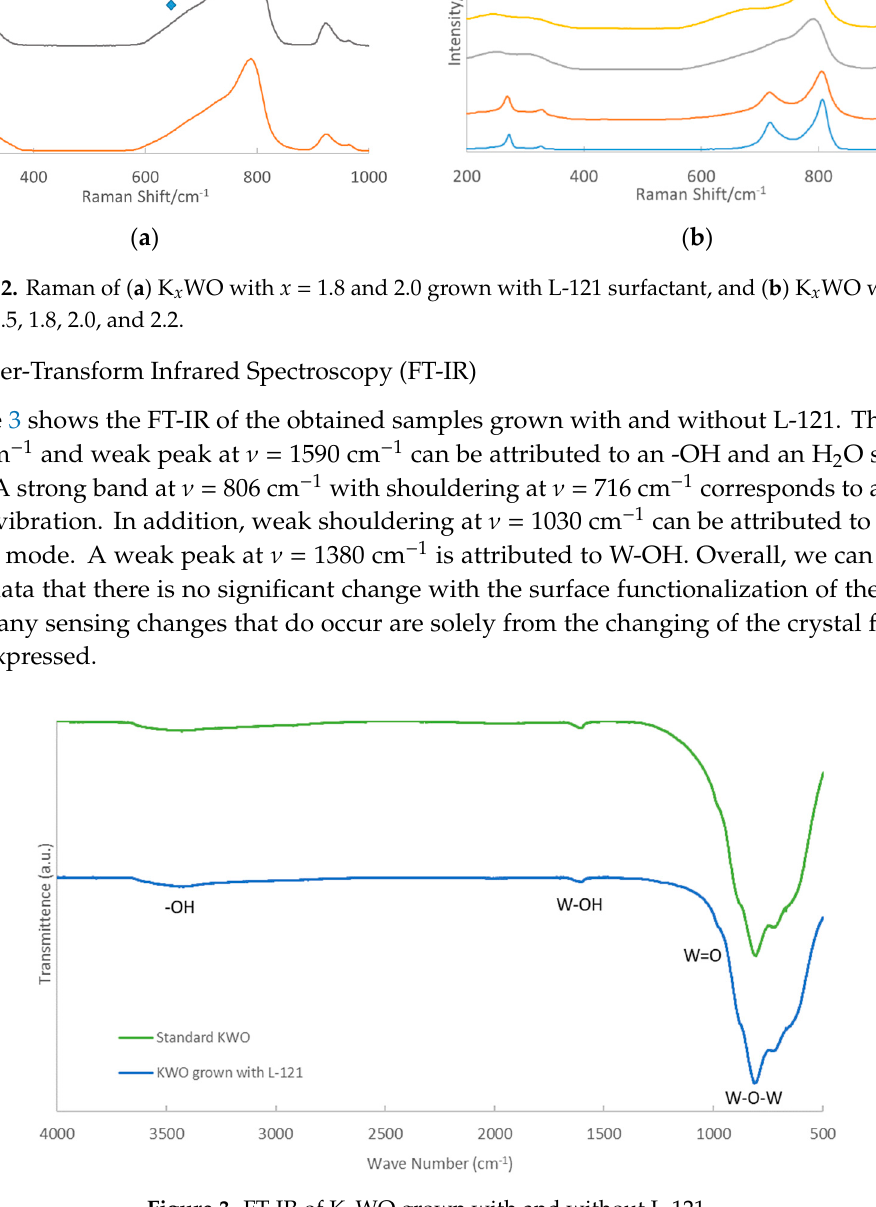
Figure 2. Raman of ( a ) K x WO with x = 1.8 and 2.0 grown with L-121 surfactant, and ( b ) K x WO with x = 1.2, 1.5, 1.8, 2.0, and 2.2.